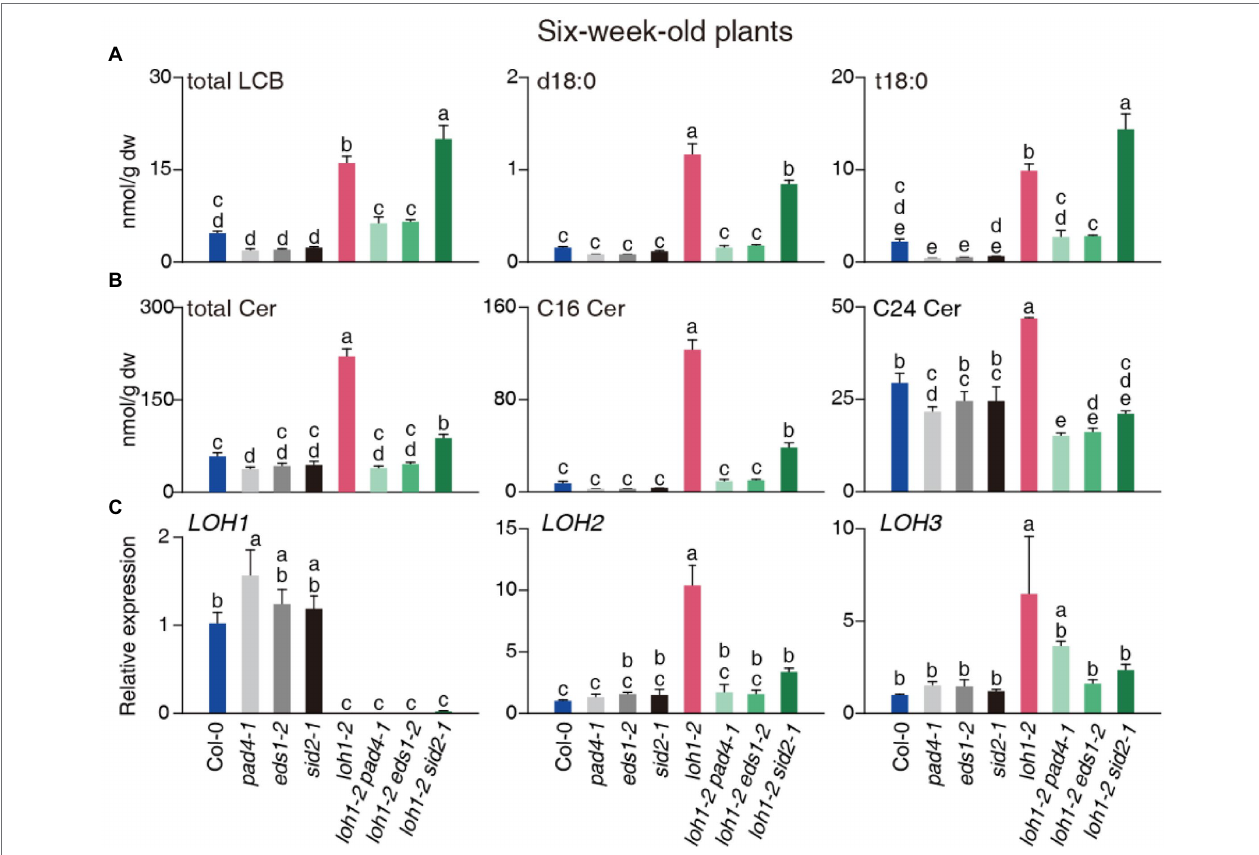
FIGURE 7 | Total sphingolipid profile of 6-week-old Col-0, pad4-1 , eds1-2 , sid2-1 , loh1-2 , loh1-2 pad4-1 , loh1-2 eds1-2 , and loh1-2 sid2-1 plants. Sphingolipids were extracted and detected by HPLC-ESI-TOF-MS/MS. (A) Total contents of total LCB, d18:0, and t18:0. (B) Total contents of total Cer, C16 Cer, and C24 Cer. (C) Relative transcript levels for LOH1 , LOH2 , and LOH3 in uninfected plants. ACT2 served as internal control. Values are means ± SE from triplicate biological repeats in (A–C) . Different letters indicate significant differences between genotypes, as determined by Fisher’s PLSD ( p < 0.05). The experiments in (A–C) were conducted three times using independent